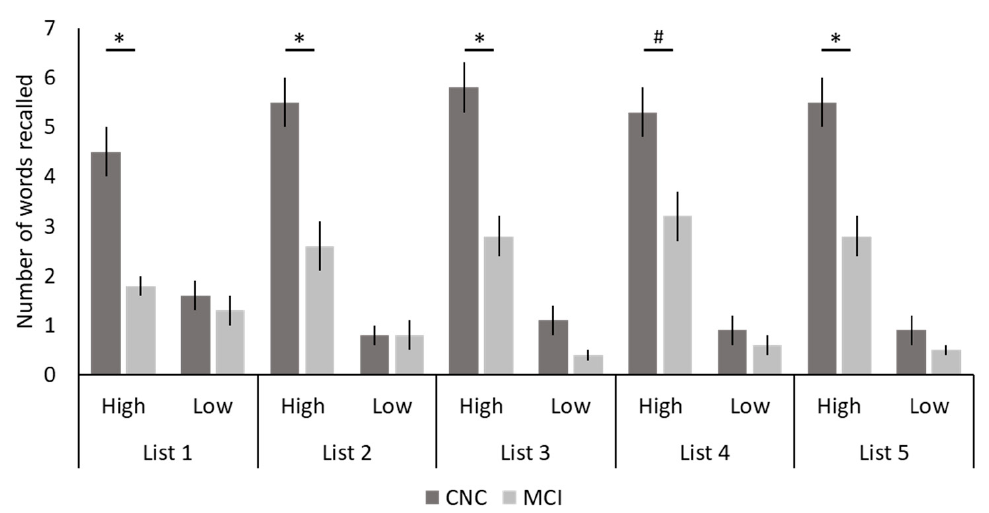
Figure 2. Task-Related Behavioral Data. The number of high- and low-value words recalled across the five lists for both cognitively normal older controls (CNCs) and individuals with mild cognitive impairment (MCI) are shown. Bars represent standard errors. * p < 0.05; # p = 0.070 (trending).